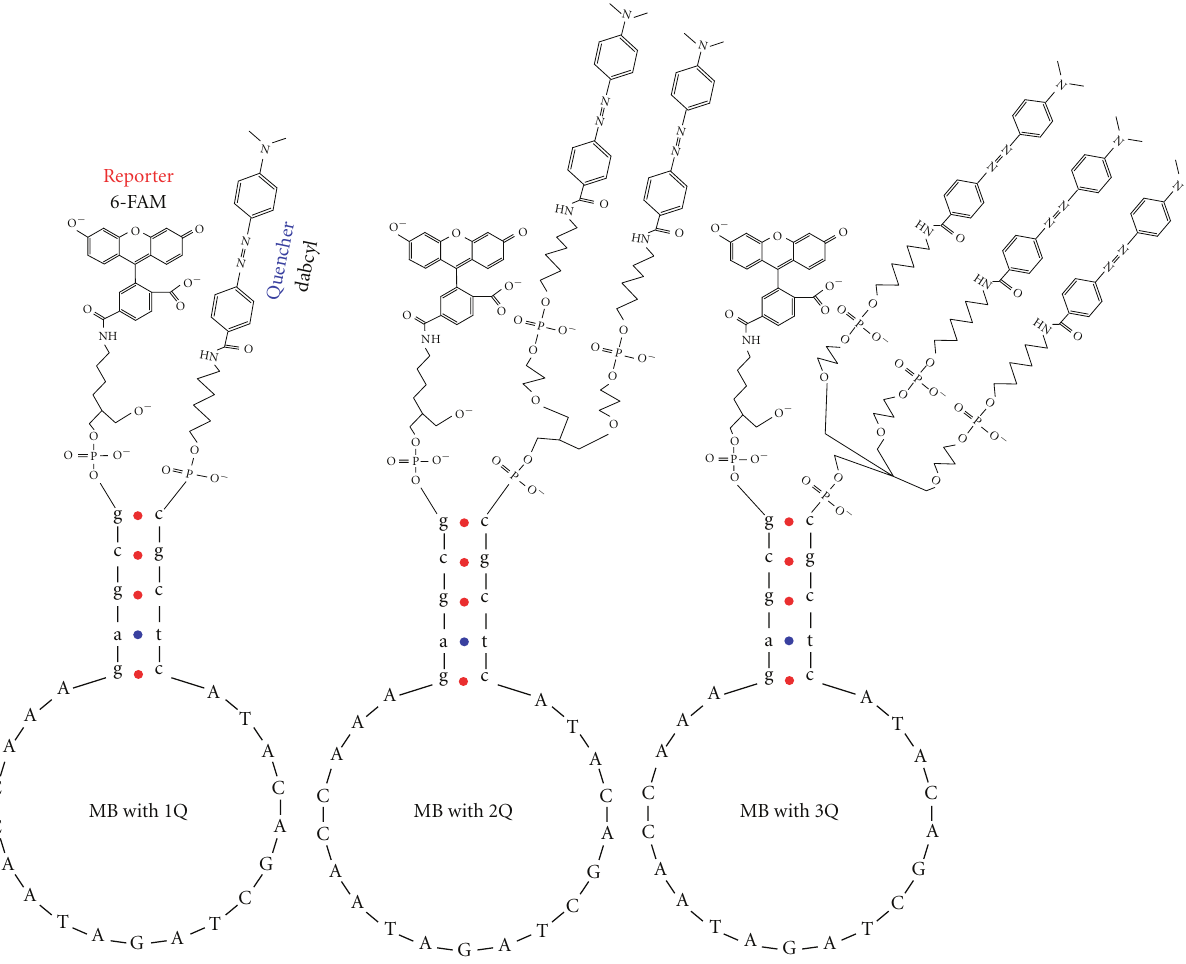
Figure 3: Structures of the superquenched MB. MB with one (1Q), two (2Q), and three (3Q) Dabcyl quenchers. The structures are represented in their oxidized state. The linker structures, the reporter linked to the 3 (cid:2) end and the quencher or quenchers attached at the 5 (cid:2) terminus correspond to